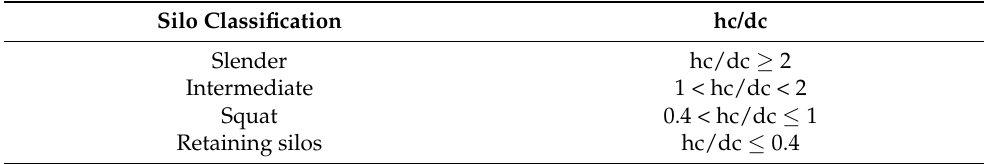
Table 4. Silo classifications according to EN1991-4 (d c = a, for square